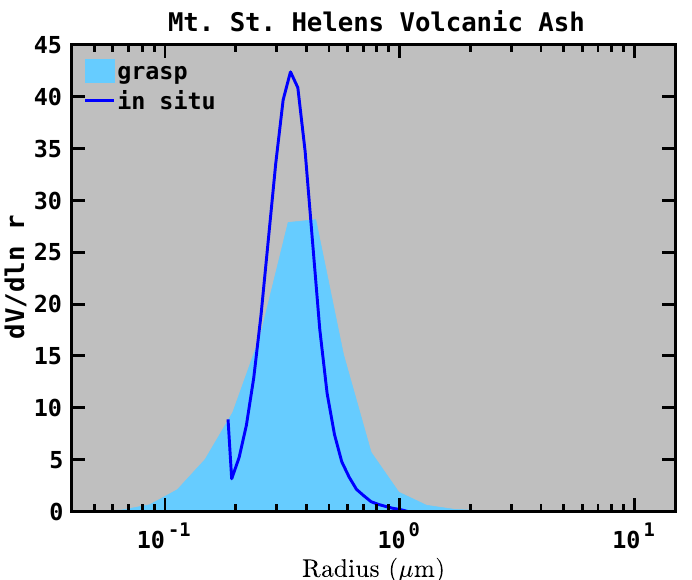
Figure 8. Comparison of retrieved size distribution (GRASP) with APS measurements of equivalent volume spheres for dry PM 1 volcanic ash that was erupted from Mount St. Helens. The GRASP size distribution was obtained using a simulated solar zenith angle of 50 ◦ , and the APS aerodynamic size measurements were converted to equivalent volume spheres using a dynamic shape factor of χ ∗ = 1.25; this is the minimum χ -value consistent with Mie theory and extinction measurements (as discussed in Section 4.3). Relative bias of the GRASP effective variance with respect to APS measurements for this case is 2.94, which is close to the average variance bias of 2.80 shown in Table 3 at θ ◦ = 50 ◦